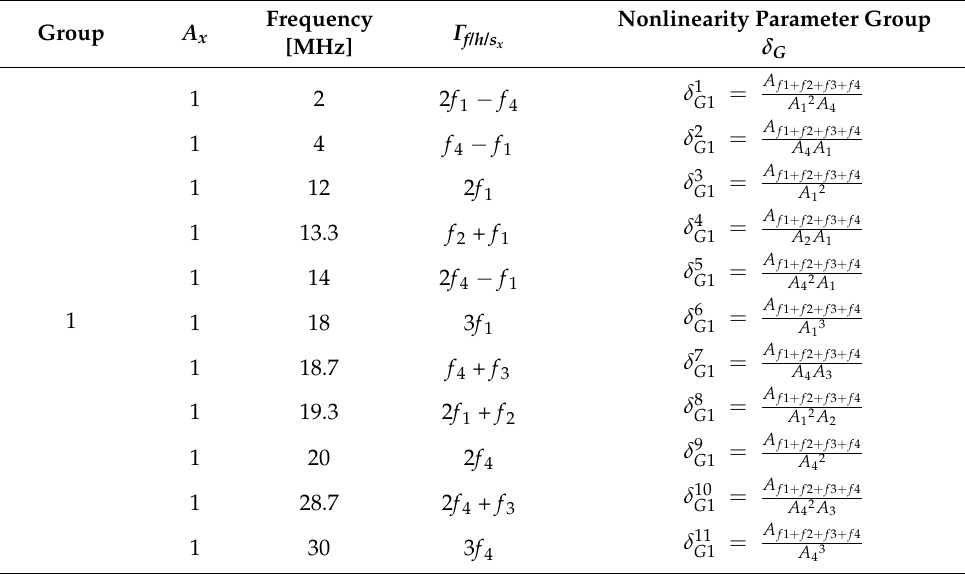
Table 2. Nonlinearity parameter group 1, δ G 1 .